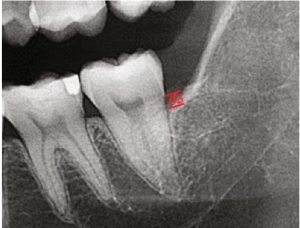
Figure 3: Data were measured at 6 months after surgery